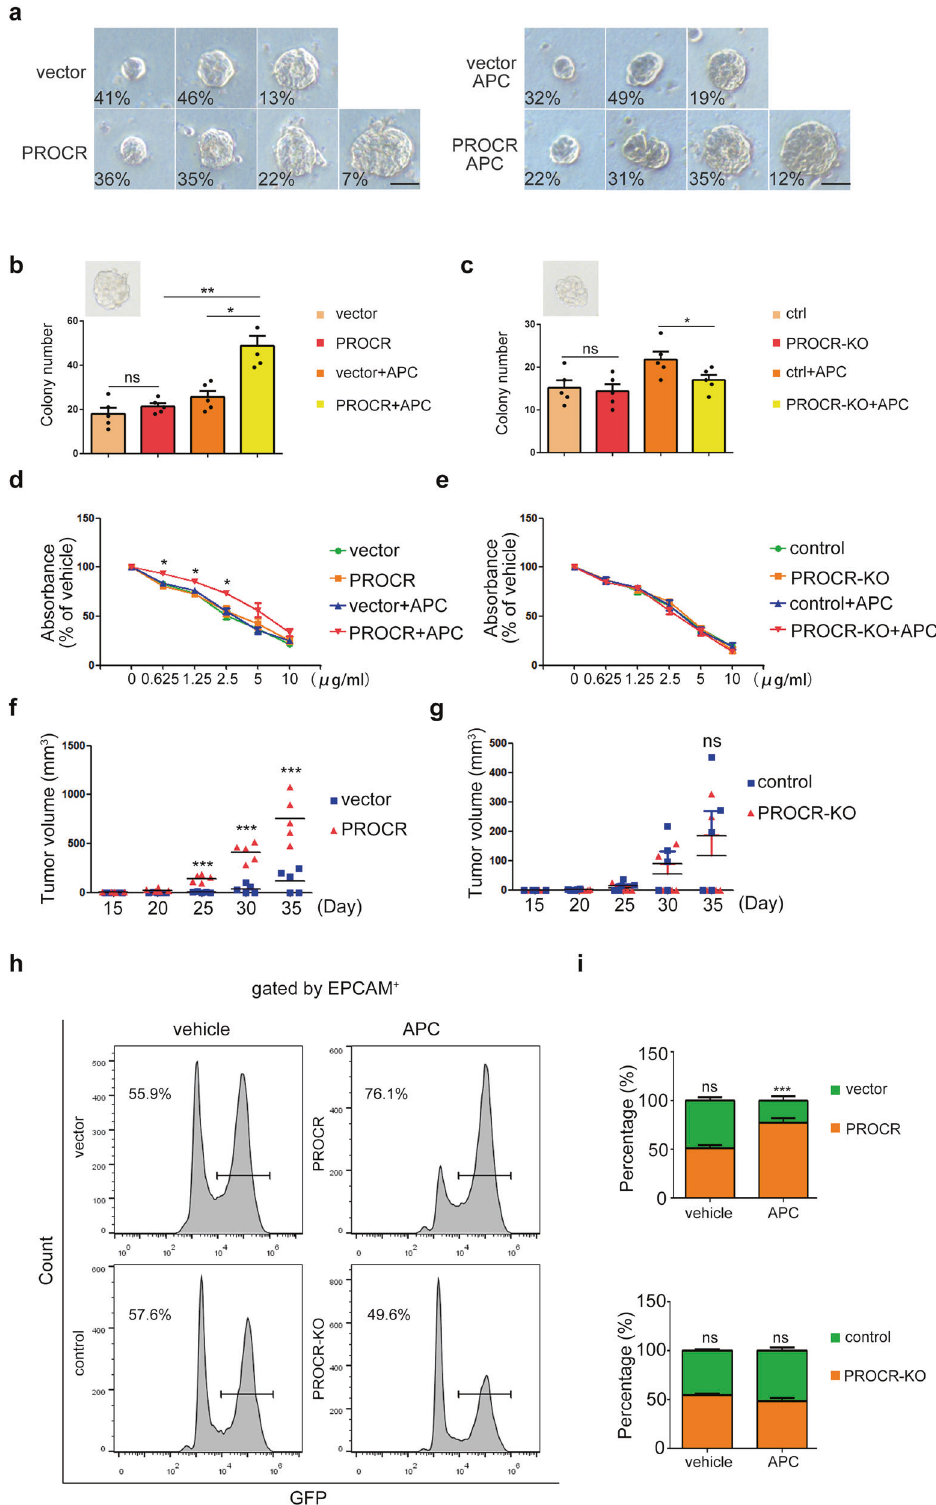
Fig. 2 PROCR labels potential cancer stem cell in NPC. a Various tumorspheres distribution formed by 5 – 8 F cells. The scale bar denotes 50 µm. b , c Quanti fi cation of the tumorspheres with PROCR overexpression or knockout. The eligible tumor sphere is screened with a diameter greater than 50 µm. d , e CCK-8 assay of the PROCR overexpression or knockout cells with DDP treatment at different dosages. f , g Growth curves of the volume of subcutaneous xenograft tumors; n = 5 for each group. A total of 1 × 10 6 tumor cells together with APC (300 μ mol) were diluted into 200 μ l phosphate-buffered saline (PBS) solution for subcutaneous transplantation. From 2 to 4 weeks, the APC (300 μ mol) were treated by tail vein injection. h , i Flow cytometry analysis of the GFP + cells from xenograft tumors in mice lungs, and their corresponding statistical analysis. APC was treated by tail vein injection. ns, not signi fi cant, * P < 0.05, ** P < 0.01, *** P < 0.001